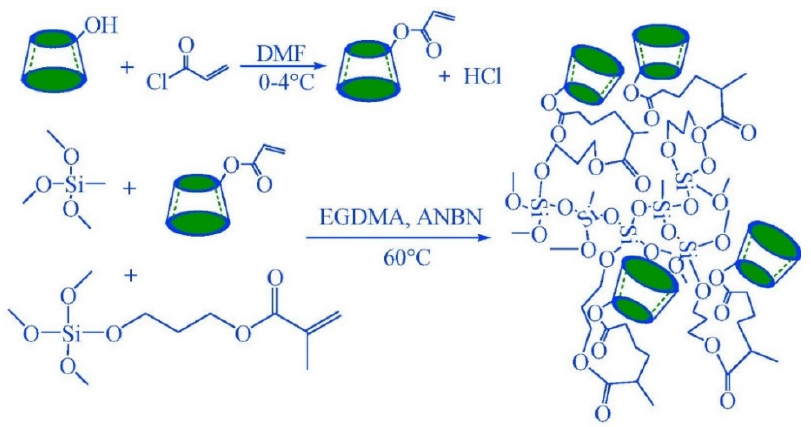
Figure 8. Scheme for the obtaining of an acryloyl β -CD–silica monolith column. Reproduced from [94], with permission from Copyright 2018 Elsevier.